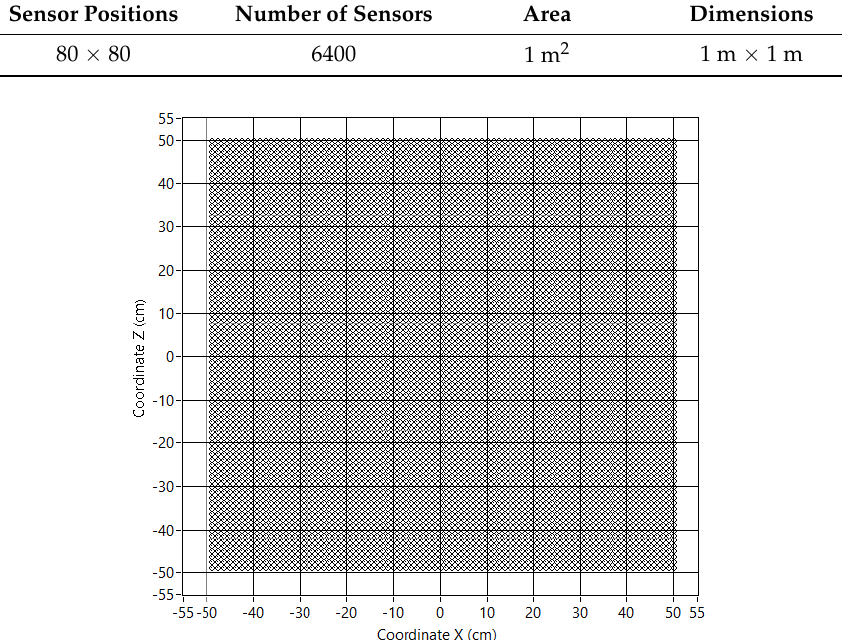
Table 1. Virtual array characteristics.